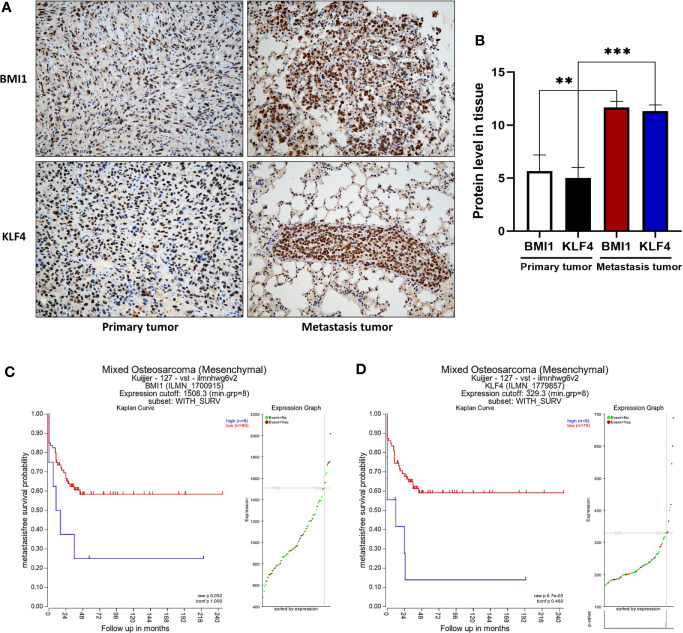
Positive BMI1 and KLF4 expression are associated with OS metastasis, and predicted a short survival time in patients. (A) Immunohistochemistry. The mouse OS cell xenografts and lung tissues were resected from the nude mice and subjected to tissue processing, embedding, sectioning, and immunohistochemistry (magnification, ×40). (B) The graph of the quantified data of immunohistochemical staining of BMI1 and KLF4. (**p < 0.01; ***p < 0.001; n = 3). (C, D) Kaplan-Meier analyses. BMI1 and KLF4 expression in OS was analyzed to predict the prognosis of OS patients by using Kaplan-Meier method on R2: Genomics Analysis and Visualization Platform. (p > 0.05; ** p < 0.01; C, D). The data were expressed as the mean ± SEM.